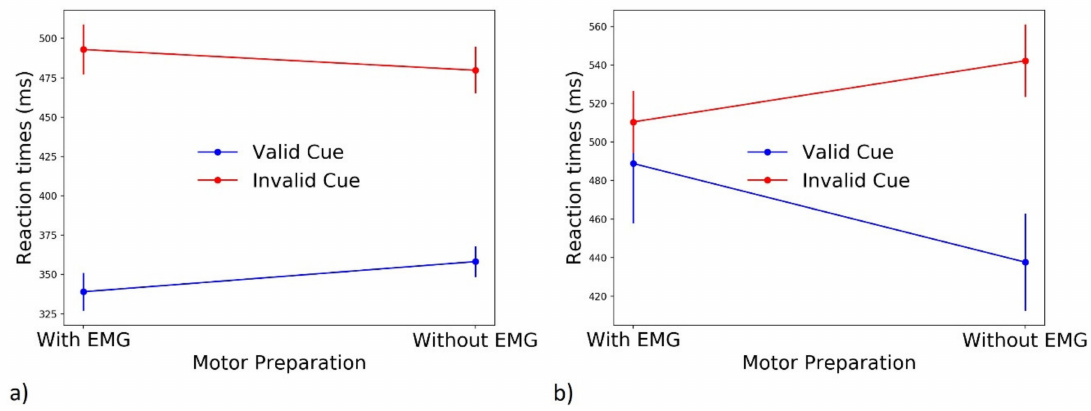
Figure 7. Average RTs for valid and invalid cue trials are plotted for pure correct ( a ) and partial errors ( b ). Error bars represent the standard